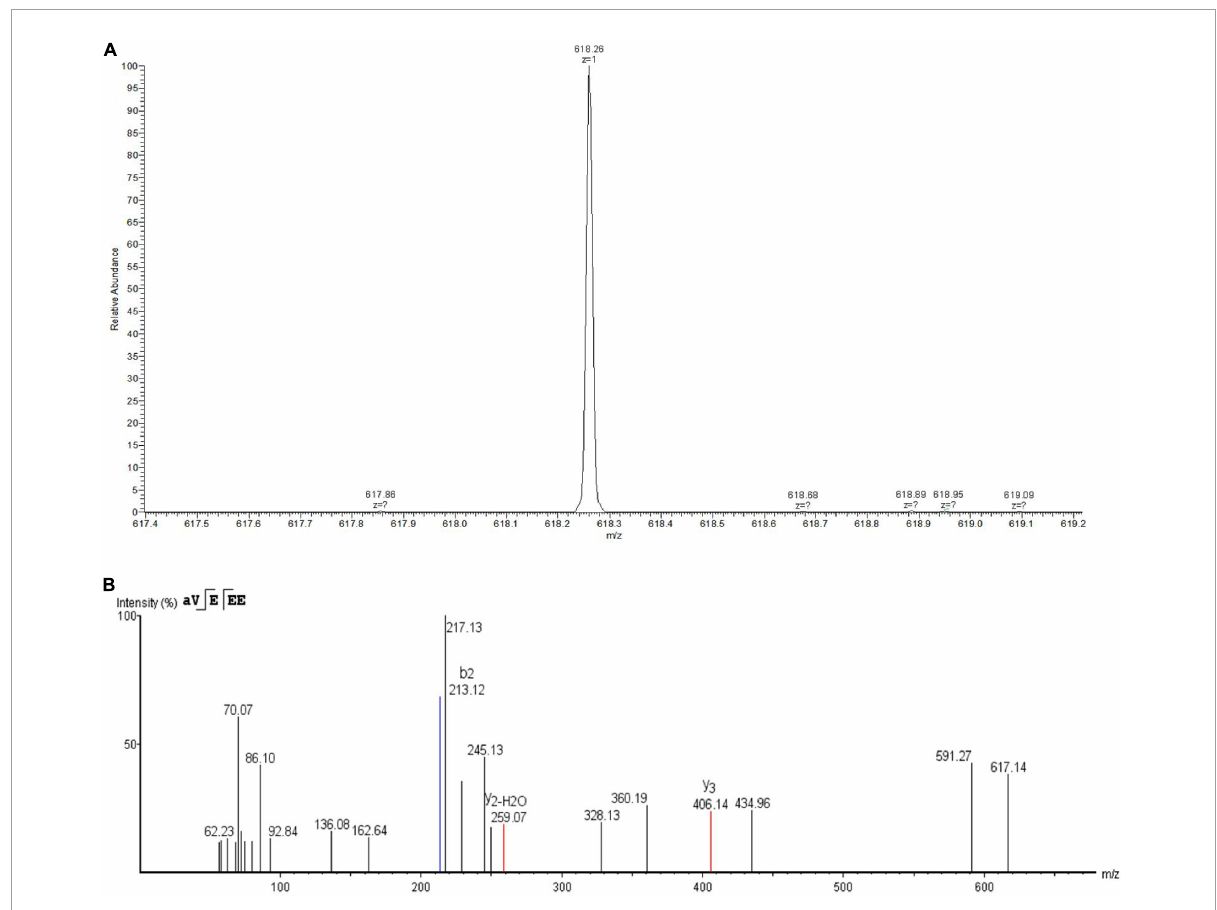
FIGURE4 Identification of plantaricin W3-2 by liquid chromatography coupled with tandem mass spectrometry (LC-MS/MS). (A) Primary mass spectrometry of plantaricin W3-2. (B) Secondary mass spectrometry of plantaricin